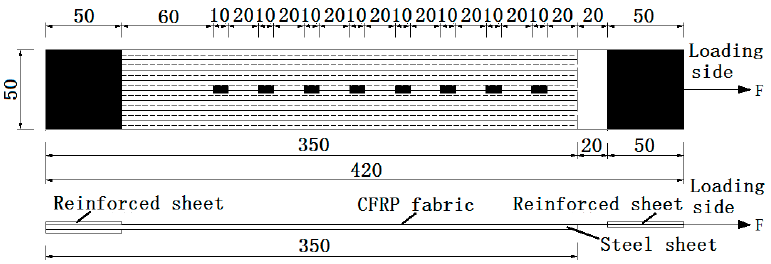
Figure 1. Layout of the CFRP fabric strains measuring points.